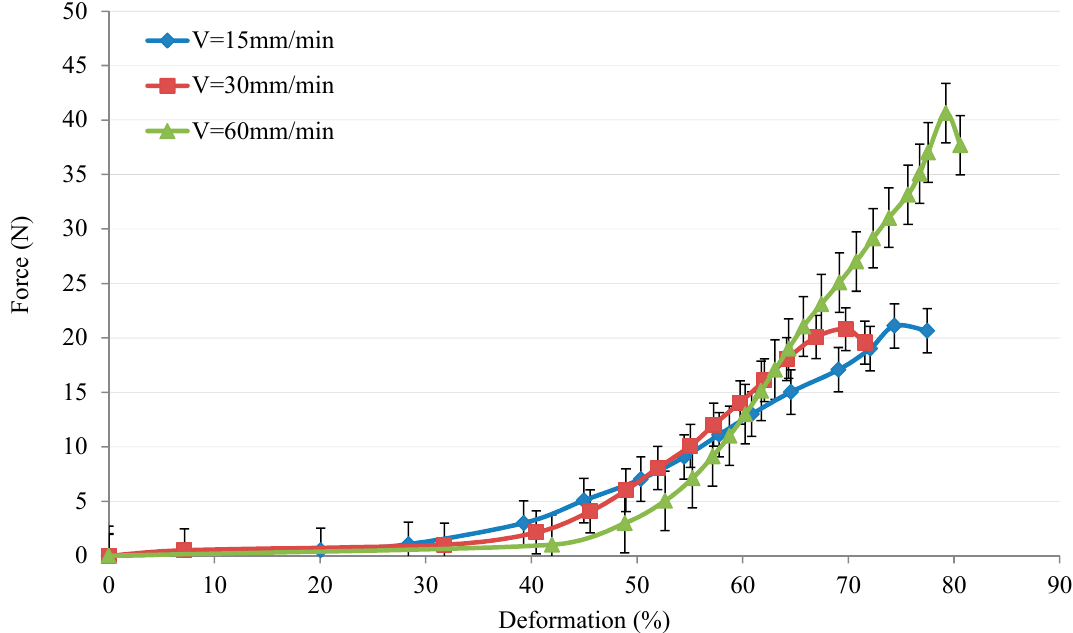
Figure 10. The load vs. deformation under variation of tensile speed at the fixed temperature.